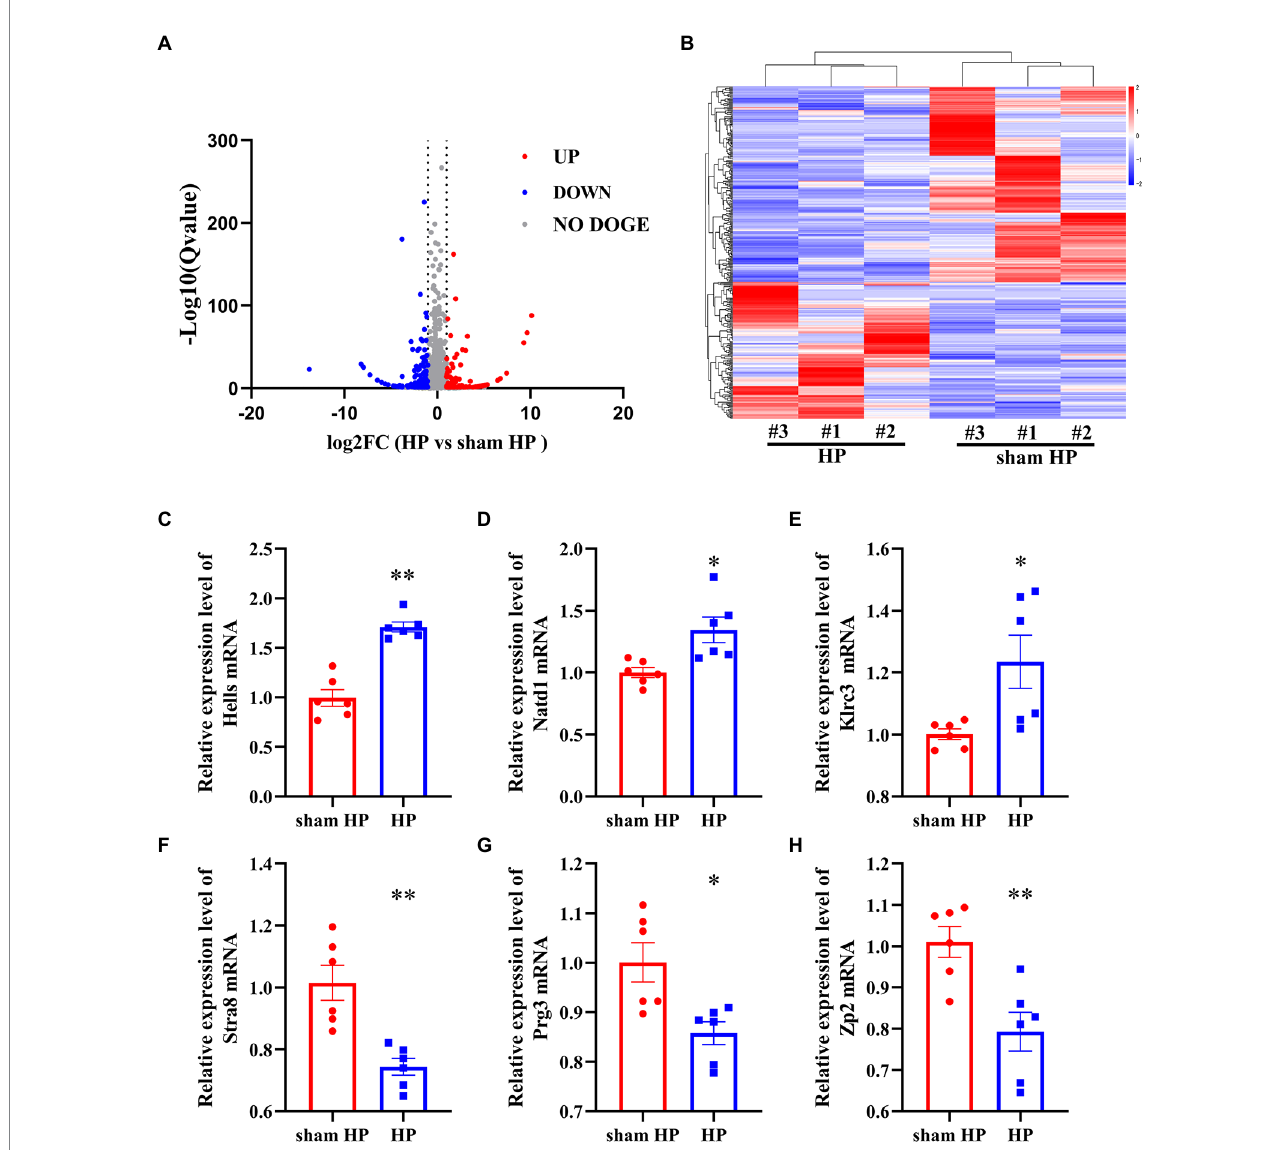
FIGURE 2 RNA-Seq reveals gene expression changes in the DRG induced by HP. (A) Volcano plot showing gene expression profiles in the ipsilateral DRG in the HP group compared with the sham group. Red and blue spots indicate up-and downregulated DeRNAs, respectively, whereas gray spots indicate non-DEGs. (B) Heatmap displaying the hierarchical clustering of DeRNAs in the HP and sham HP groups. (C–H) Validation of the RNA-Seq results via qPCR. The expression of six randomly selected DeRNAs identified by RNA-Seq was examined by qPCR. n = 6 rats per group. * p < 0.05, ** p <